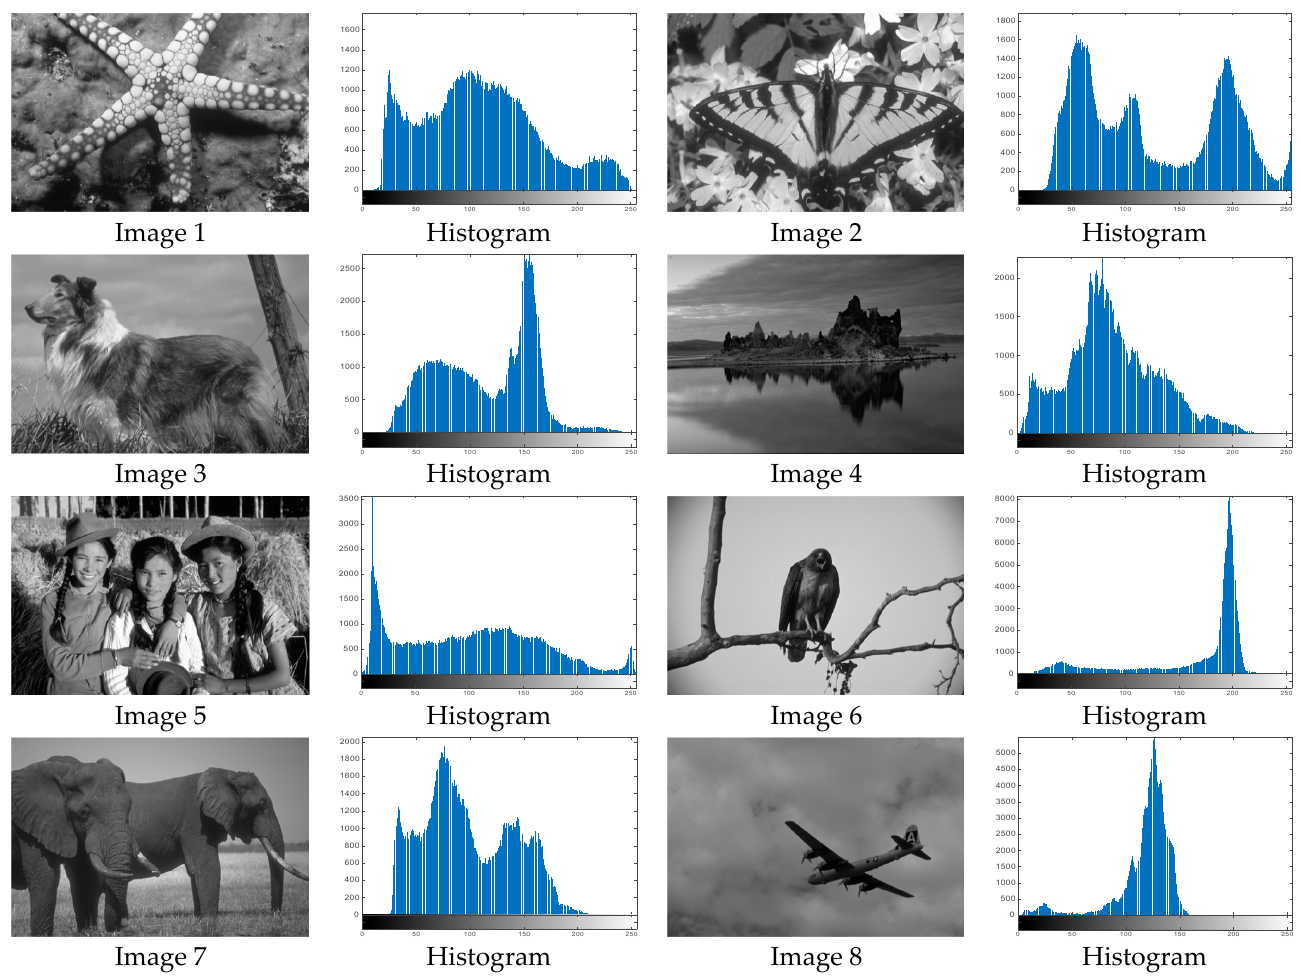
Figure 9. Berkeley image dataset and its histogram.